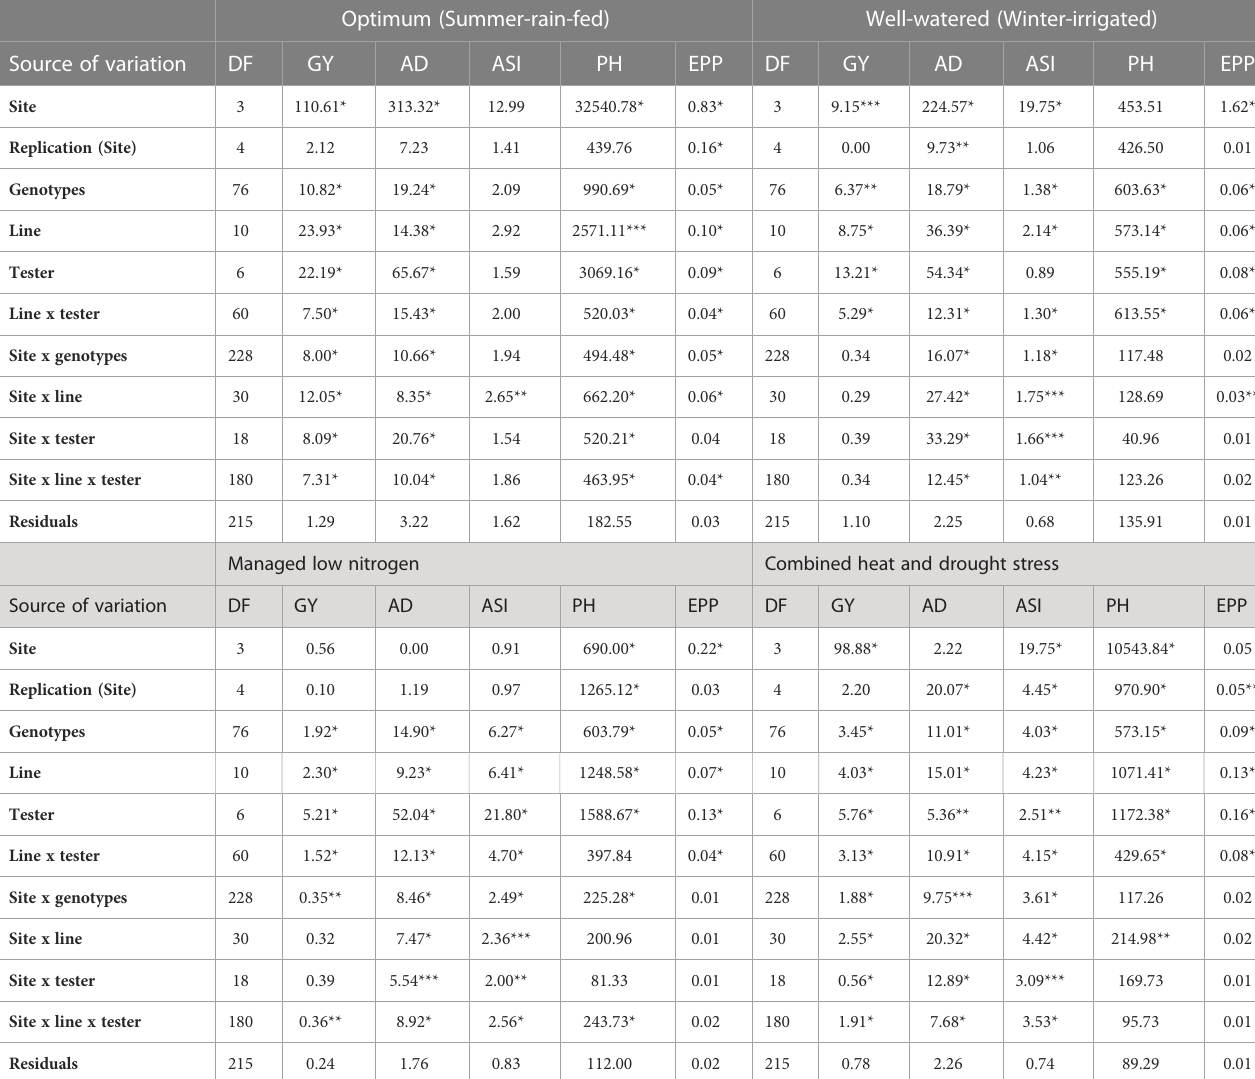
TABLE 6 Analysis of variance of F 1 crosses for grain yield and secondary traits under different management conditions. Optimum (Summer-rain-fed) Well-watered (Winter-irrigated)